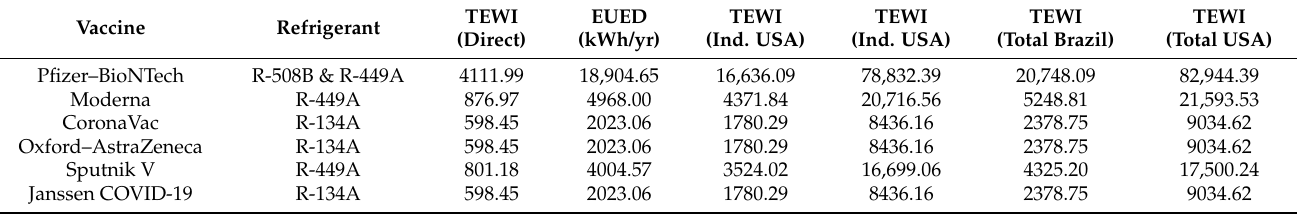
Table 5. Direct and indirect TEWI of each vaccine refrigeration system for Brazil and the USA.